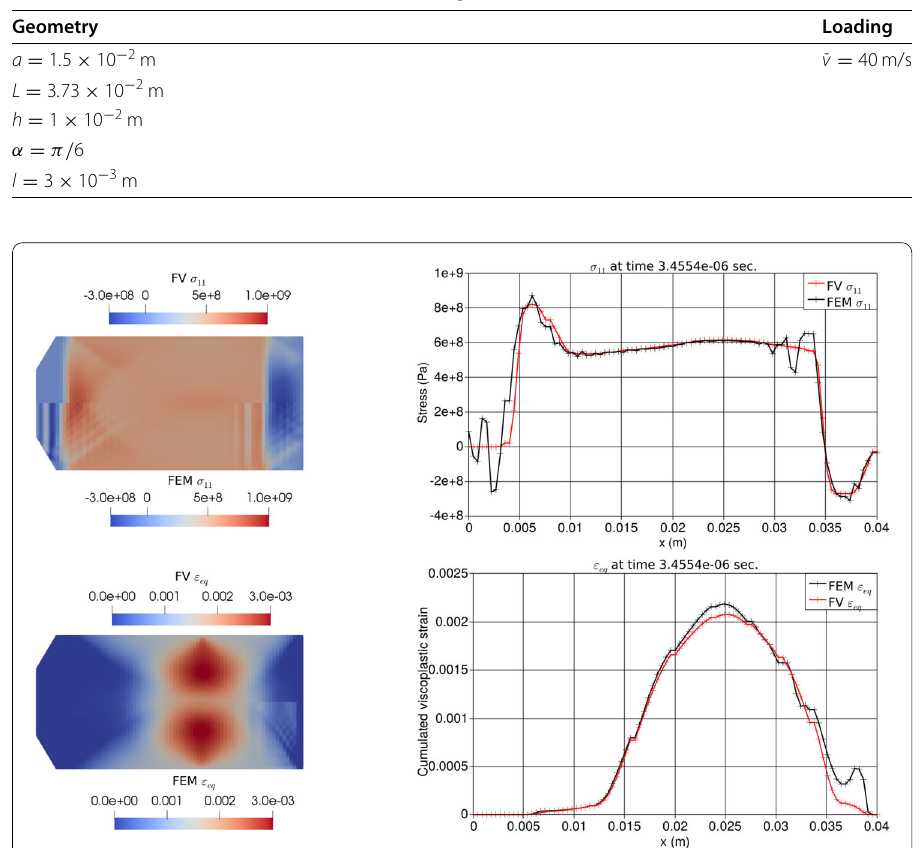
Fig. 16 Normal stress σ 11 and cumulated viscoplastic strains ε eq at time 3 . 45 × 10 − 6 s, computed with finite elements (bottom-half domain) and finite volumes (top-half domain). Superposed plots are made along the horizontal symmetry line